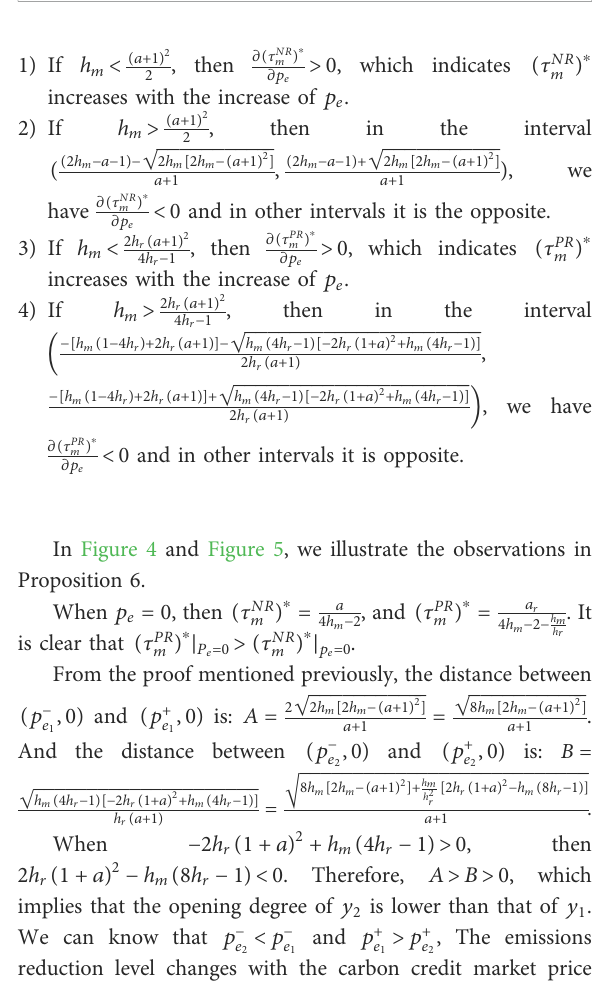
Emissions reduction level under strategies PR and